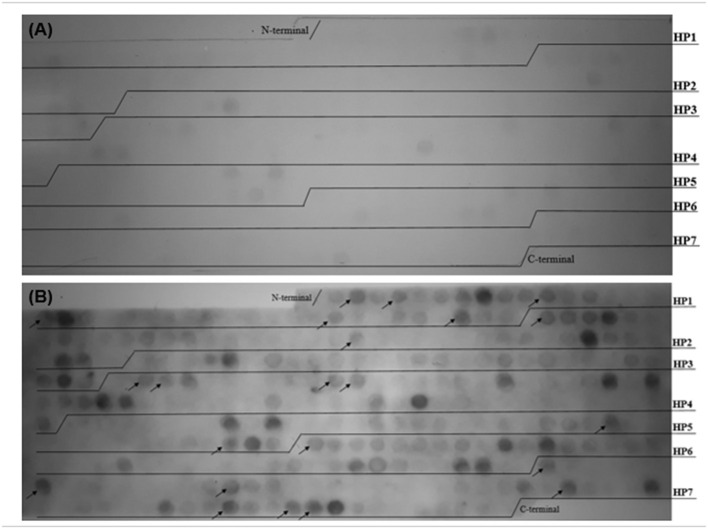
Histone proteins sequences were spot synthesized by overlapping pentadecapeptides offset by three amino acids aimed at selecting and evaluating the reactivity of epitopes on these sequences. Reactivity of peptides originated from histone proteins of Leishmania spp. with anti-L. braziliensis immunoglobulins G. (A) Reactivity of peptides with healthy patient serum without anti-Leishmania spp. IgG. (B) Reactive spots immunodetected by patient serum with antibodies for L. braziliensis and not cross-reacted with healthy patient serum (without anti-Leishmania spp. IgG). The arrows indicate the 22 peptides selected by the immunoassay.